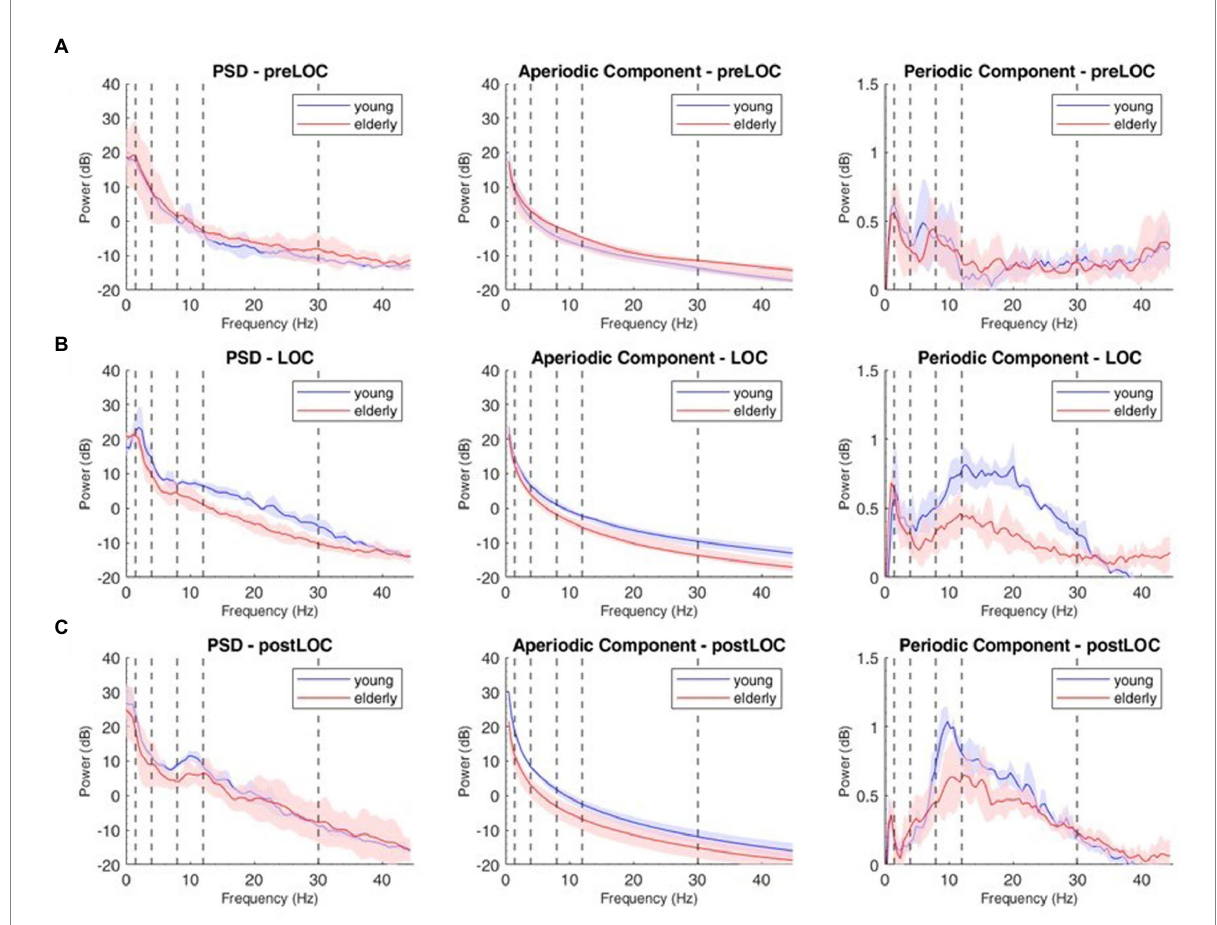
FIGURE 3 Decomposition of the power spectral density (PSD) array in its periodic and aperiodic components for the young (blue, n = 9) and elderly (red, n = 14) cohort at Fp1. Left column: raw PSD, Middle column: aperiodic component of the PSD. Right column: periodic component of the PSD at preLOC (A) , LOC (B) , postLOC (C) . Shaded Areas correspond to the interquartile range. Vertical dashed lines mark the limits of the frequency